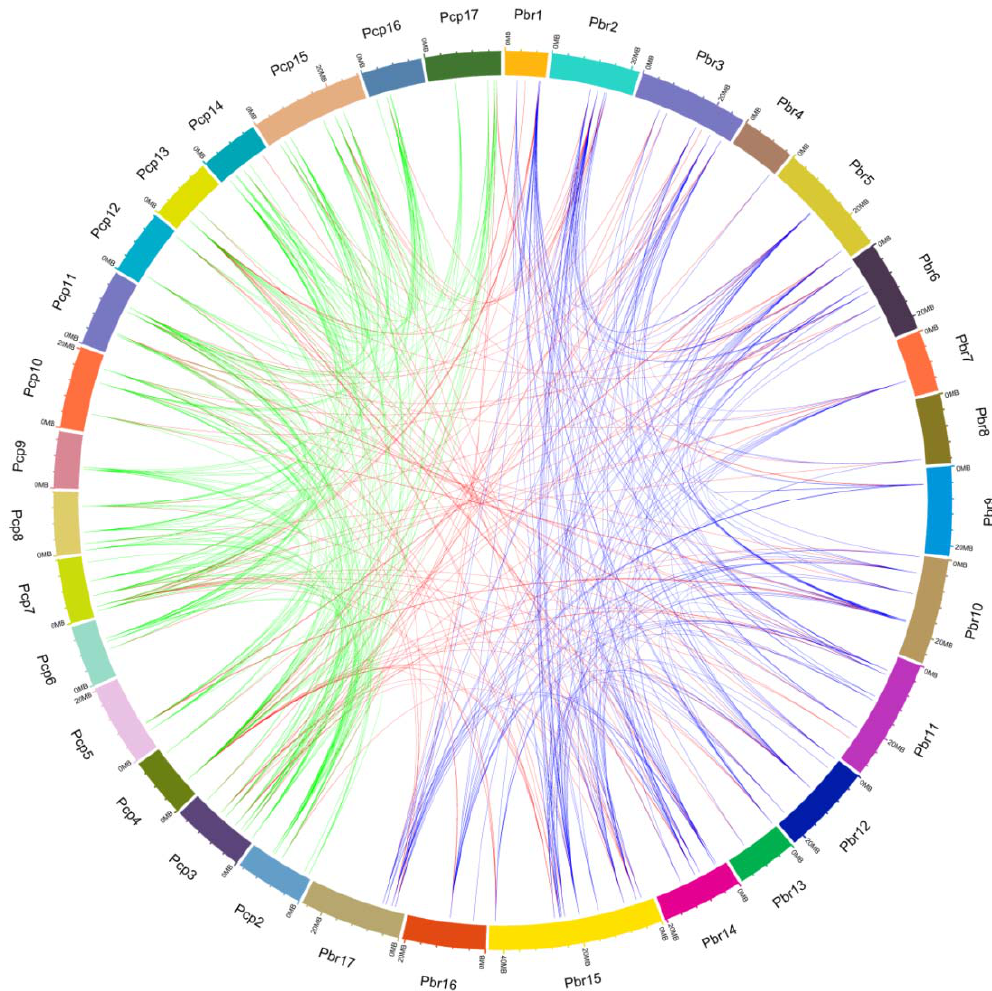
Figure 2. Microsynteny of UBC genes across P. bretschneideri and P. communis . The outermost scale represents the megabases (Mb). The P. communis and P. bretschneideri chromosomes are labeled Pcp and Pbr, and are represented by different color boxes, respectively. Blue, green, and red lines represent the P. bretschneideri paralogous gene pairs, P. communis paralogous gene pairs, and orthologous gene pairs, respectively.